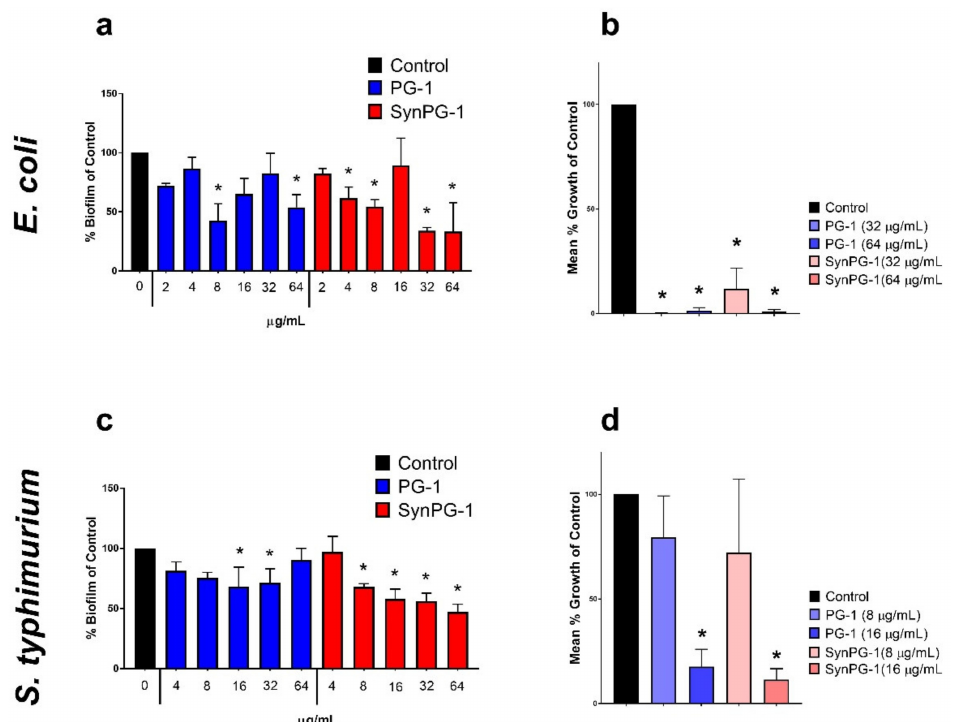
Figure 6. E ff ect of 3 h treatment with PG-1 and SynPG-1 on the destruction of pre-formed biofilm of ( a ) E. coli and ( c ) S. typhimurium , represented as the mean ± SEM of % biofilm of the control of three independent experiments, where n = 6. The asterisks represent significant di ff erences at p < 0.05, when compared to the control by two-way ANOVA with a post hoc Tukey test. The e ff ect of PG-1 and SynPG-1 on the viability of ( b ) E. coli and ( d ) S. typhimurium colonies, represented as the mean ± SEM of the relative mean % growth of control of three independent experiments performed in duplicate. The asterisks represent significant di ff erences at p < 0.05, when compared with one-way ANOVA with a post hoc Tukey